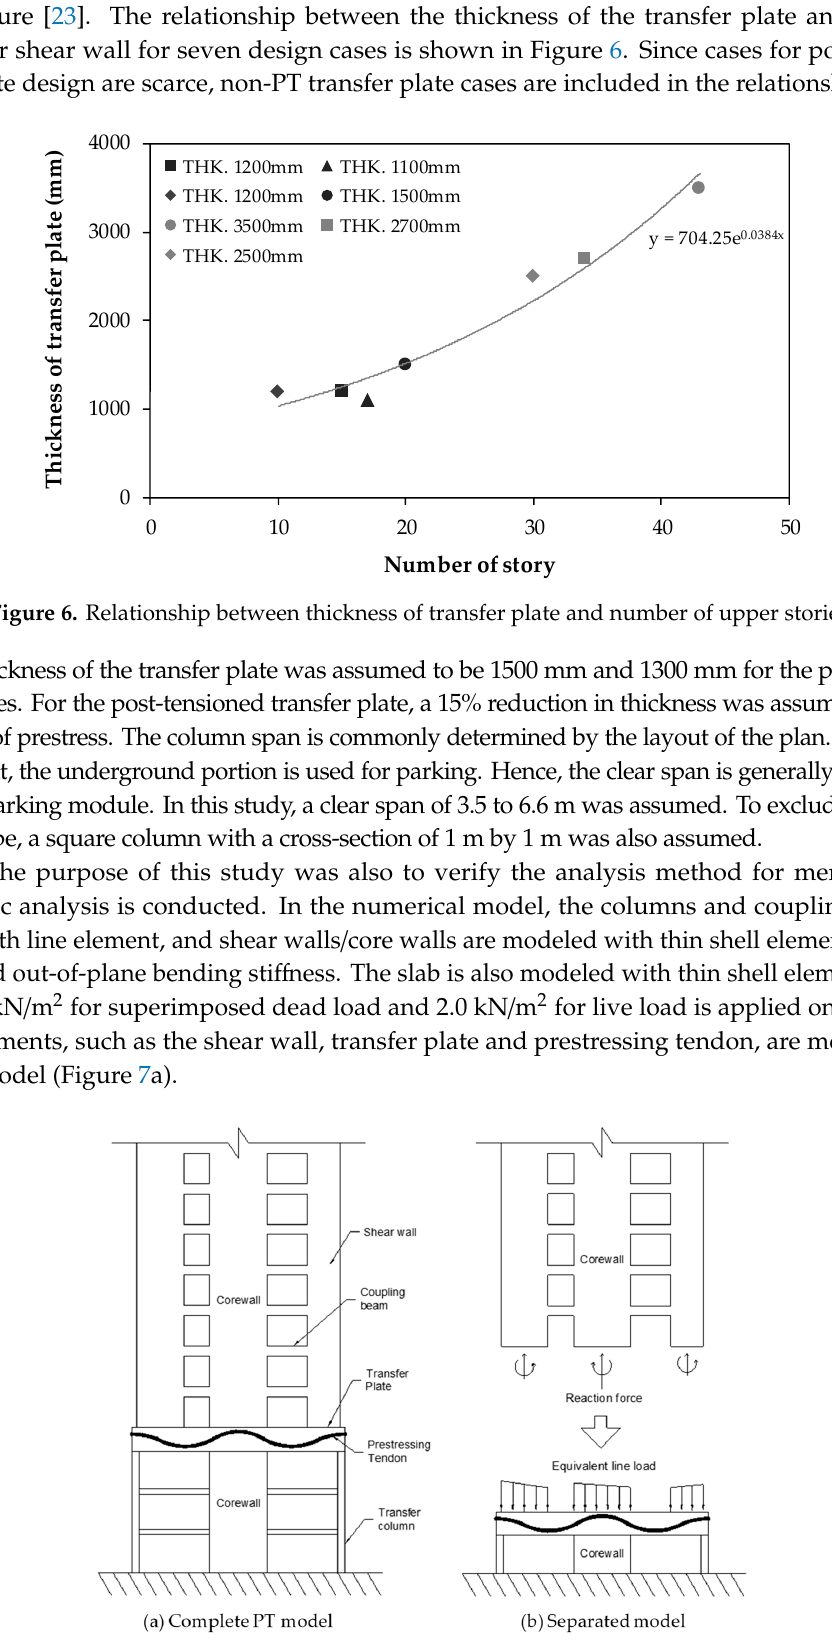
Figure 7. Concept of two analysis modeling methods. ( a ) Complete model and ( b ) Separated